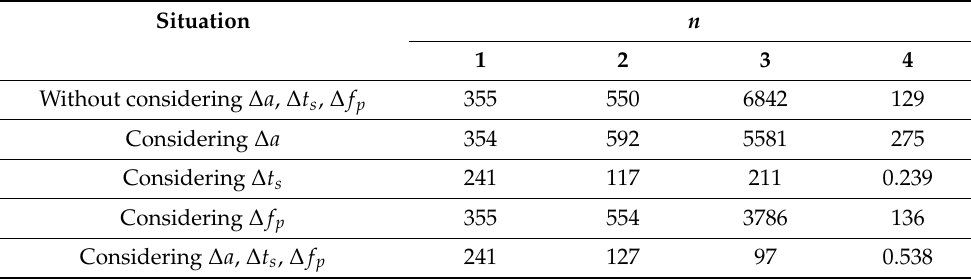
Table 12. Acceleration response contributions from each of the harmonic